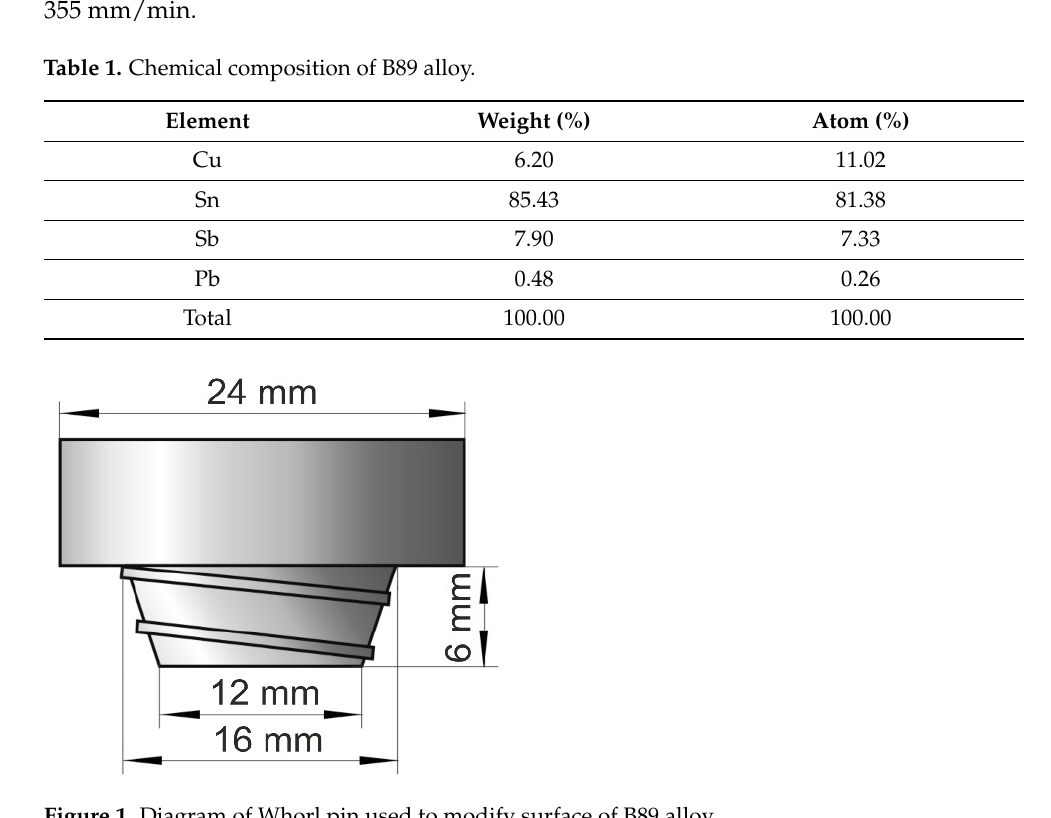
chemical composition in micro-areas was performed using a scanning electron microscope